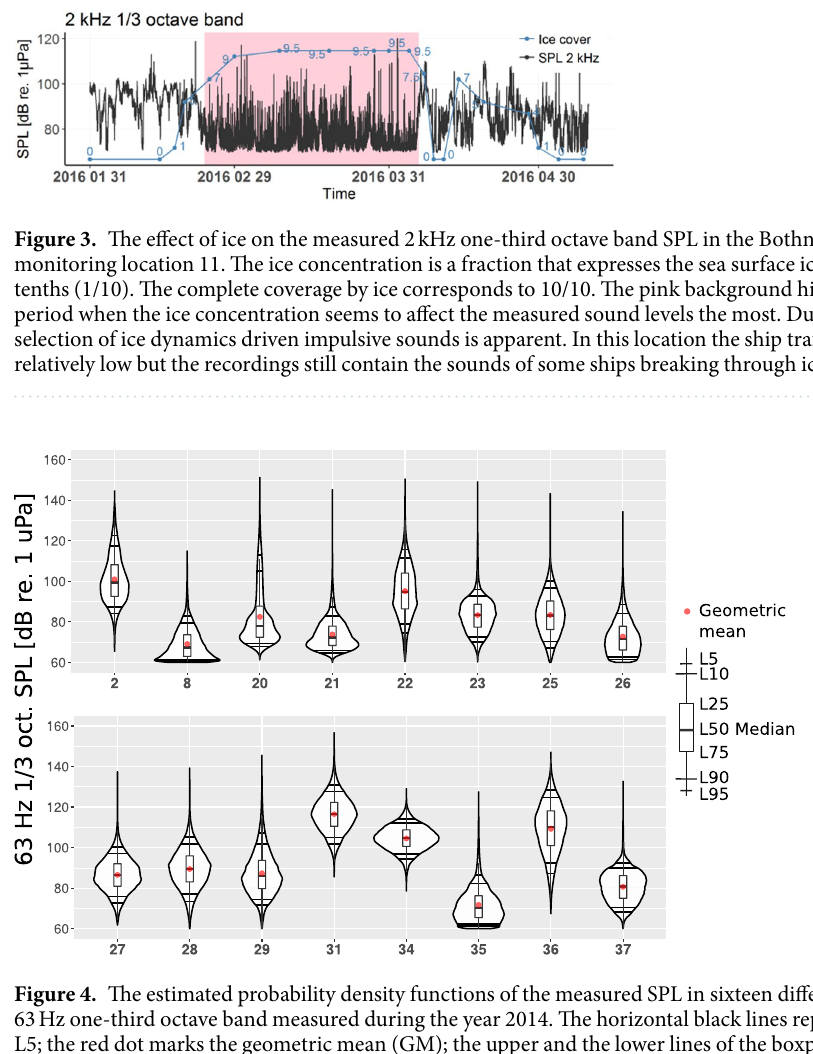
Figure 4 shows that half of the 63 Hz one-third octave band PDF-s (locations 2, 8, 20, 21, 22, 26, 29, 35) are asymmetric and visibly positively skewed as they have long thin upper tail and fatter lower tail. Only one PDF (location 36) has a visibly longer lower tail. Figure 5 shows that the 125 Hz one-third octave band PDFs are more symmetric when compared to the 63 Hz one-third octave band. In this octave band, the PDFs are still mostly pos- itively skewed. The PDF of location 37 shows the largest negative skewness in the 125 Hz one-third octave band. The long and thin upper tails of the PDF plots are related to the rarely occurring loud events that in most cases are close passages of vessels. The differences in the upper ends of the tails indicate that the recorders were not subject to significant clipping. This was also confirmed by the clipping tests performed on the data during the processing. In contrast to the lower frequency bands, the 2 kHz one-third octave band PDFs in Fig. 6 show an average nega- tive skew. This negative skew is largest for the PDF of monitoring location 37 where the ship traffic intensity is the lowest (Fig. 2). Figure 6 also shows that the largest positive skew is in location 31 that had the highest ship traffic intensity. The overall negative skew of the 2 kHz one-third octave band indicates the dominance of natural sound sources in this frequency range. The lower tails of the violin plots are bounded by the limit imposed by the self-noise level of the SM2M recorder standard hydrophone with no gain (Table 2). In monitoring locations 8, 26 and 35, there might have occurred relatively low SPL values, often well below the self-noise level. These low levels could not have been recorded, instead, they were replaced by the recorders self-noise values. An example of a time series of the SPL values where the noise floor was reached is presented in Fig. 3. This “piling up” of self-noise values seems to cause the local maxima apparent in lower tails of the PDFs. The SPL values that are below the self-noise can be related to the lower sea states in sheltered waters. In order to avoid hitting the noise floor equipment with lower self-noise should be used. It is important to note that while the geometric mean values are affected by occurrence of self-noise, the median or exceedance levels L5, L10, L25 remain unaffected. When the effect of the self-noise level on the violin plots is acknowledged, they are still very useful for interpreting the soundscape at a specific location.